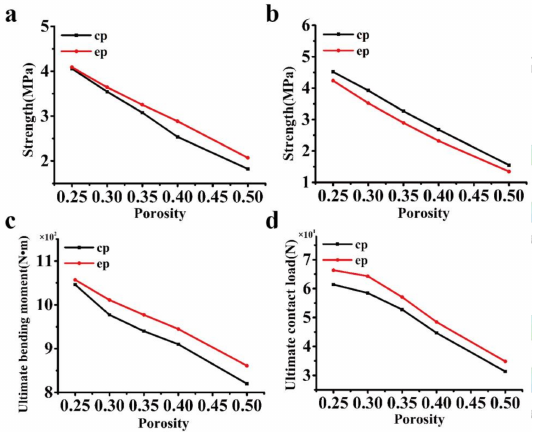
Figure 9. Comparison of the ultimate strength under different porosities: ( a – d ) ultimate strength according to the loading cases in Figure